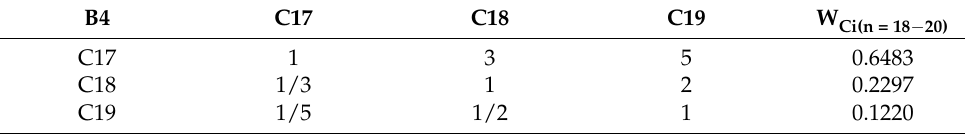
Table A5. B4-C i(i = 17 − 19) Judgment Matrix and Consistency